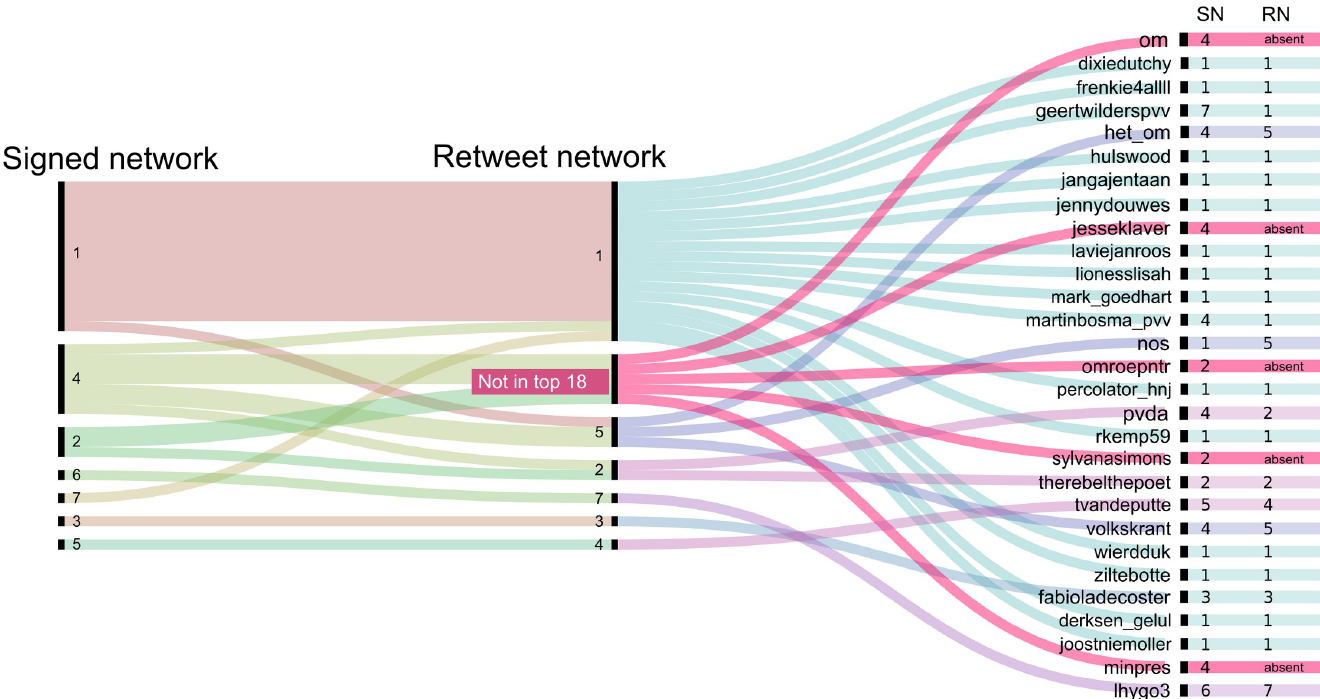
Fig 6. Community differences top actors. Alluvial graph illustrating the communities of the top 20 actors in the debate in the signed (left) versus retweet network (right). The figure shows considerable differences in the group structures and illustrates that some of these top actors in the debate, such as prime minister Mark Rutte (minpres), are not present in the top 18 communities of the retweet